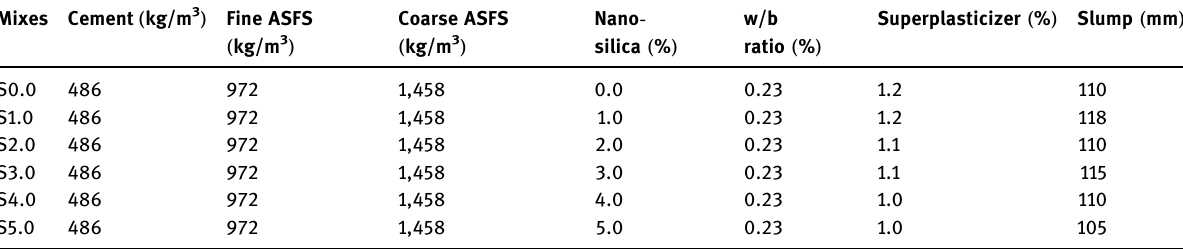
Mixes Cement ( kg/m 3 ) Fine ASFS